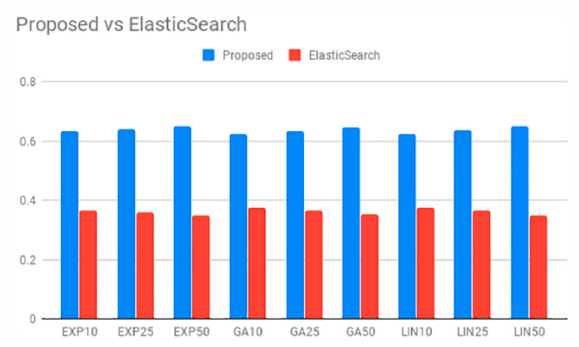
Figure 11. Test results of different ElasticSearch algorithms versus the proposed system in a pre-rated dataset.